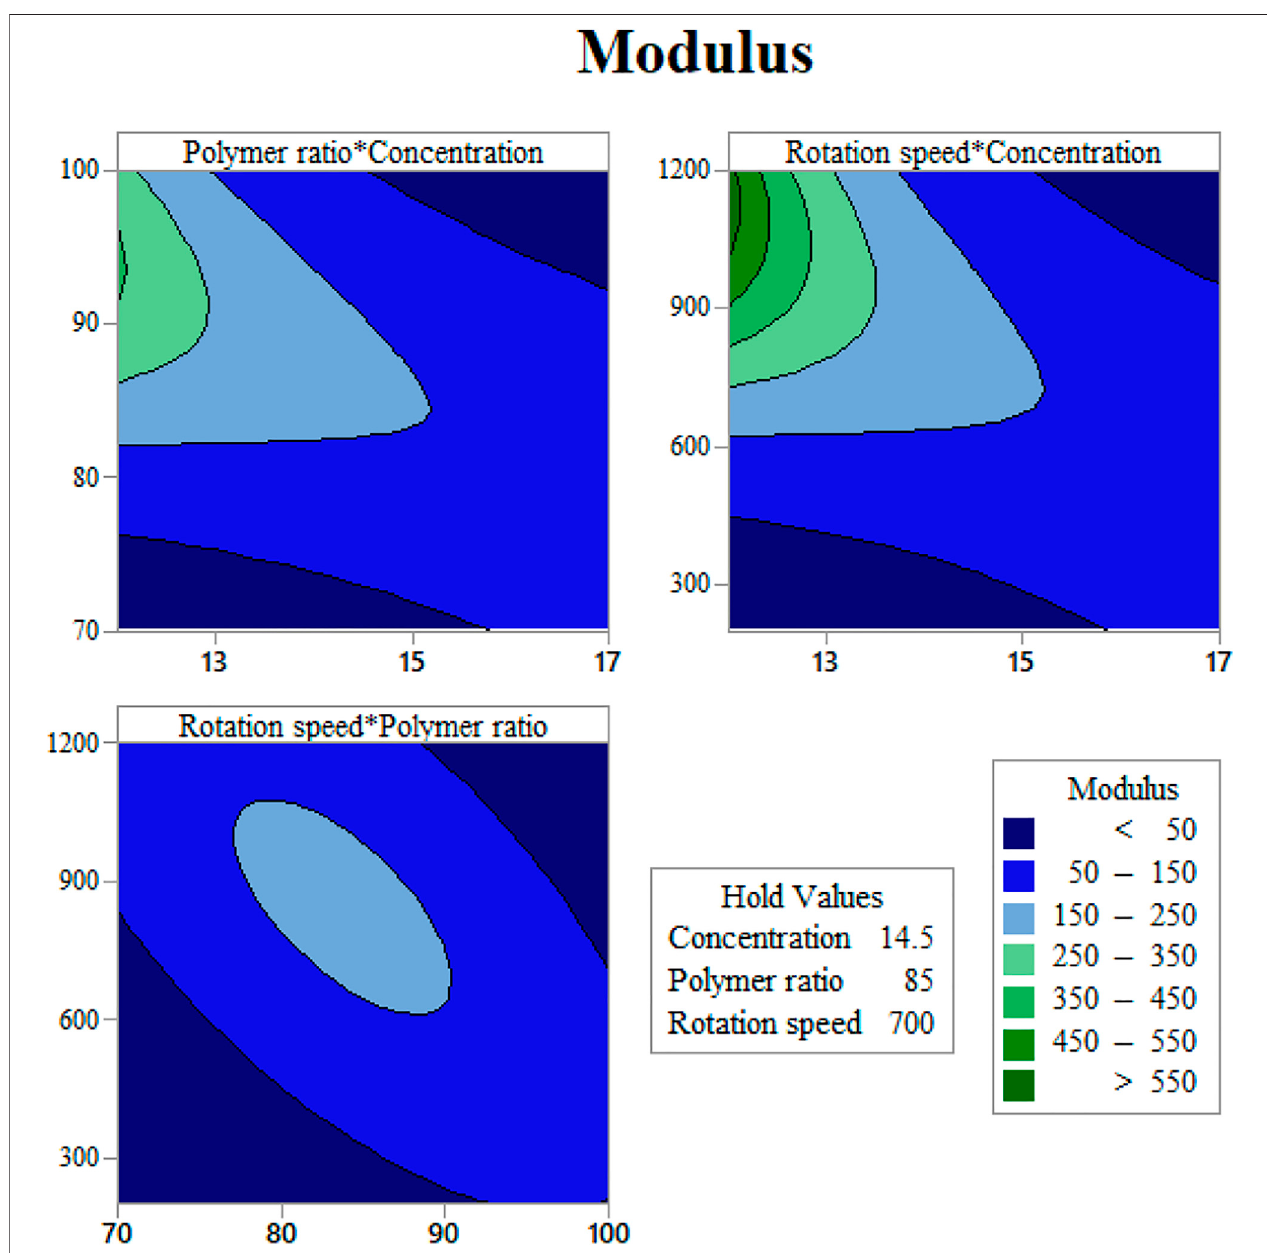
FIGURE 4 | Elastic modulus contours as functions of the input variables: (A) gelatin content vs. concentration, (B) mandrel rotation speed vs. concentration, and (C) mandrel rotation speed vs. gelatin content.